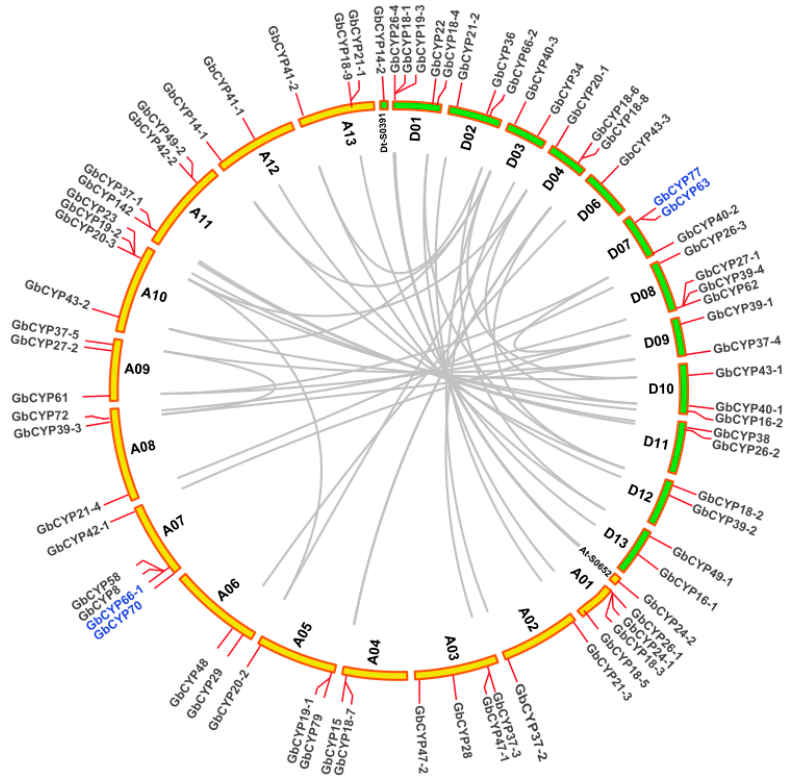
Figure 4. Chromosomal localisations and duplications of CYP genes on G. barbadense chromosomes. The duplicated CYP genes are indicated with grey lines and tandemly duplicated genes are marked with blue.